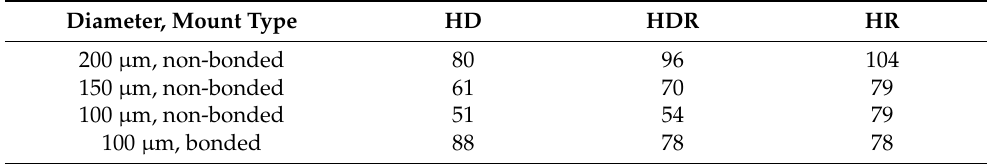
Table 1. The characteristic temperature of the threshold current density for CW mode pumping T 0CW (K) of HDs, HDRs and HRs of various diameters and mounting types. Diameter, Mount Type HD HDR HR 200 µ m, non-bonded 80